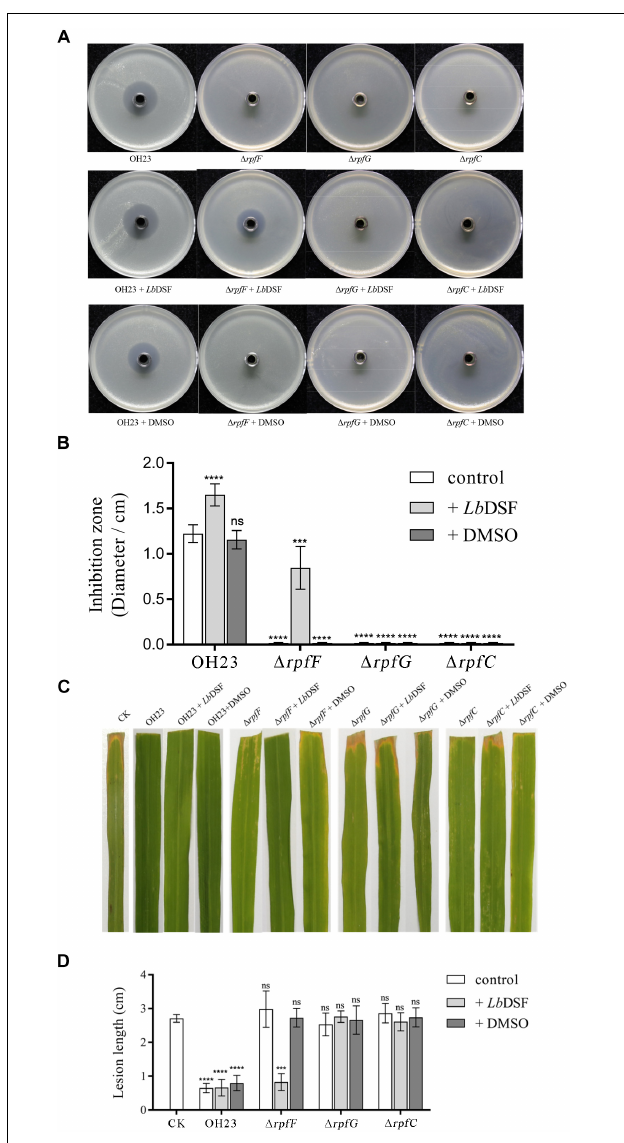
FIGURE 3 | Anti- Xanthomonas activity of L. brunescens OH23 and its corresponding rpf mutants with or without Lb DSF addition. (A) Supernatants from L. brunescens OH23 or rpf mutant cultures with or without exogenous Lb DSF supplementation were tested for their antimicrobial activity against X. oryzae pv. oryzae PXO99 A . (B) The analysis of the images of X. oryzae pv. oryzae PXO99 A growth inhibition zones shown in A. (C) Representative images of IR24 leaves infected with X. oryzae pv. oryzae PXO99 A and treated with test supernatants. CK is the control, which was treated with water every 24 h. Images were taken 7 days post-inoculation (dpi). (D) Analysis of the lesion lengths on IR24 rice leaves caused by X. oryzae pv. oryzae PXO99 A infection with or without treatment with test supernatants, as shown in C . Different numbers of star ( ∗ ) above the bars indicate a significant difference between the wild-type strain OH23 and mutant strains (ns: not sigificant, ∗∗∗ P < 0.001; ∗∗∗∗ P < 0.001, t -test).